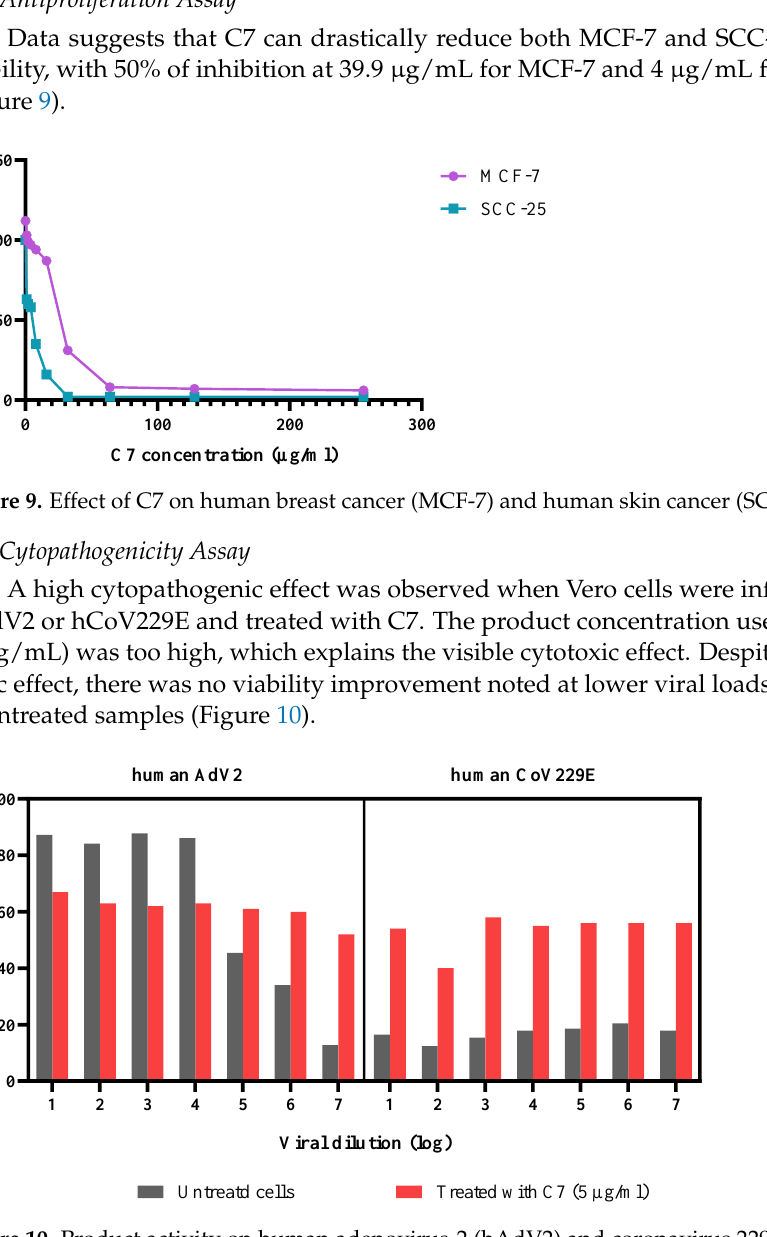
Figure 10. Product activity on human adenovirus-2 (hAdV2) and coronavirus 229E (hCoV229E) at different viral